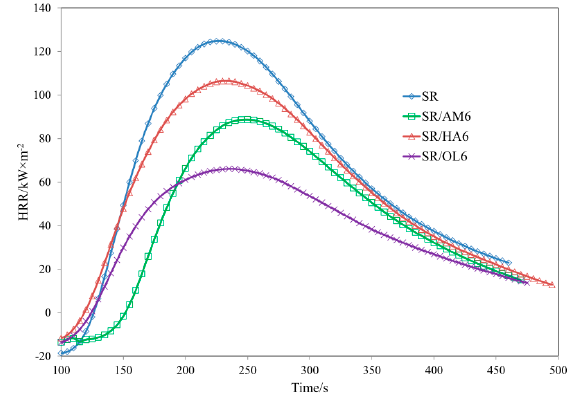
Figure 9. HRR curves of SR/POSS composites.